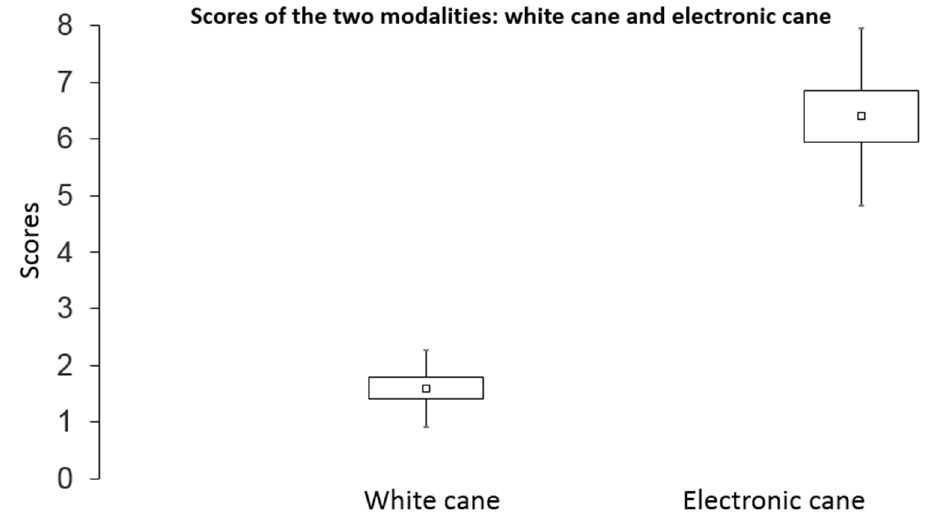
Figure 7. Effect of using the simple white cane and Tom Pouce III on the mobility score (±SD = error bar; ±SE =